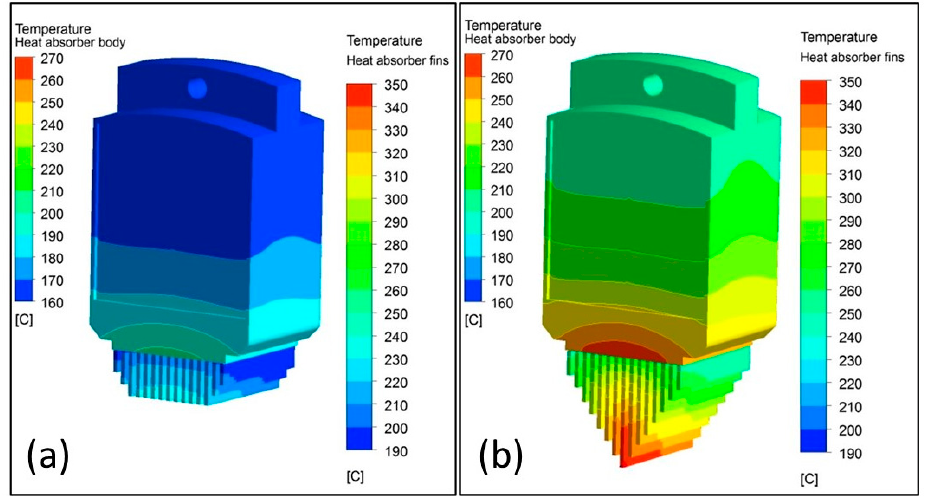
Figure 10. Temperature of the heat absorber (body and fins in different color scales for clarity) for case 8, with a total fin surface area equal to ( a ) A t,o (=418 cm 2 for the whole ATEG) and ( b ) 1.6 A t,o . The maximum electrical output power P ATEG per each case of Figure 9 is depicted in Figure 11. Since P ATEG is proportional to Δ T 2 , the average increase in P ATEG with reference to the initial design tested in the engine bench (Section 2) was 23%, 49%, and 75% when the total fin surface area of the absorber increased by 20%, 40%, and 60%, respectively. In case 8, the maximum output power for the 1.6 A t,o heat absorber type reached 76 W, in comparison with the 46 W obtained with the A t,o case. In case of using the modules with ZTe = 0.63, the output power would rise up to 228 W and 138 W, respectively. Figure 11 . Electrical output power for the cases shown in Figure 3 when using heat absorbers with different total surface area A t . Numerical results. The efficiency η TEM of the heat to electricity conversion can be calculated from the electrical output power of a single TEM P TEM (= P ATEG /10) and the heat flow through its hot side Q h :